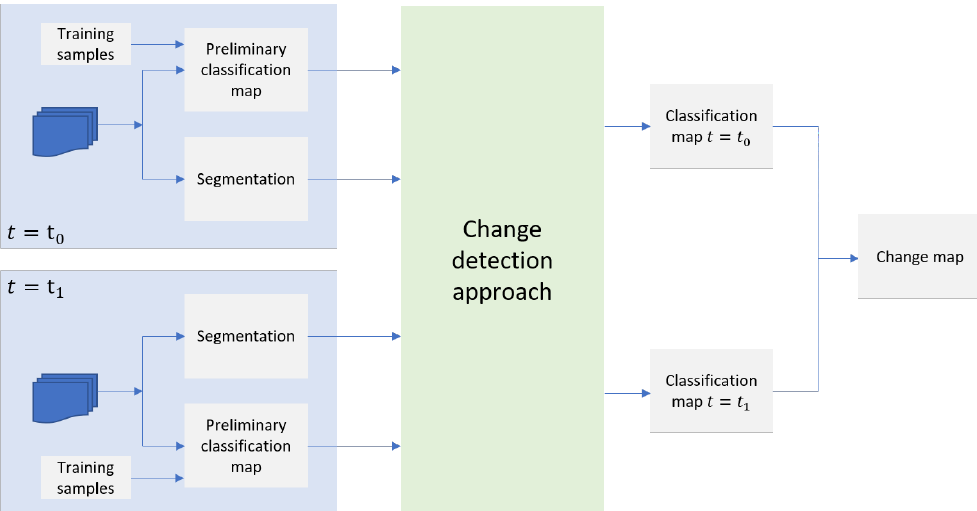
Figure 5. Block diagram of the proposed method. The products are the two classification maps corresponding to the two acquisition dates ( 𝑡 0 and 𝑡 1 ) and the change map identifying changes and specifying the transitions between land covers occurring between 𝑡 0 and 𝑡 1 .